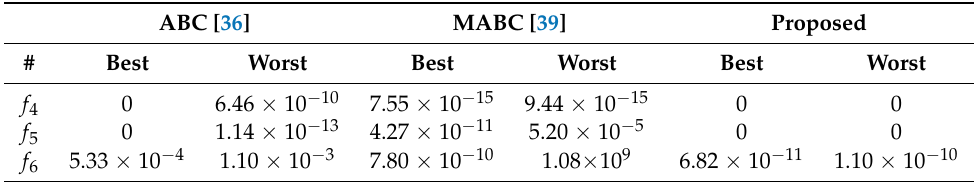
Table 4. Comparison of the obtained results for the variants of ABC algorithm in large-scale benchmark